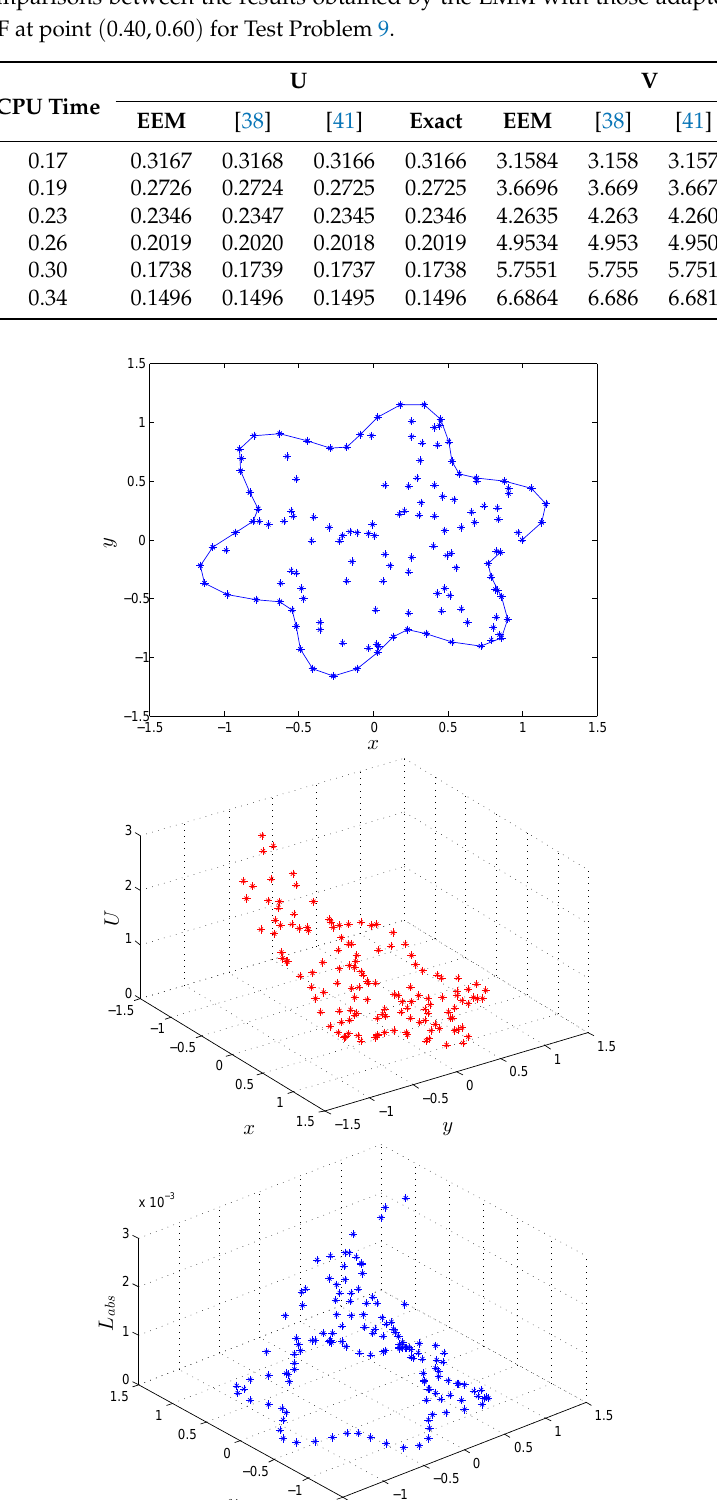
Figure 3. Computational domain ( a ), numerical solution ( b ) and absolute error ( c ) by using the EEM for Test Problem